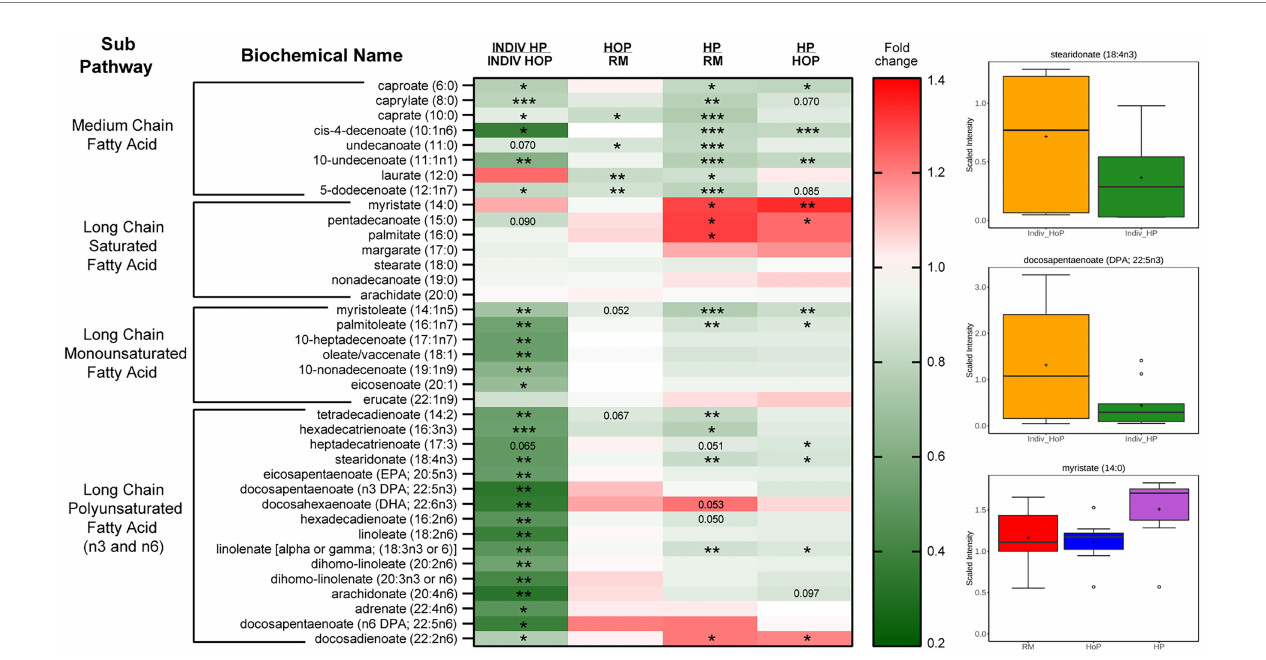
FIGURE 3 Heatmap (abbreviated) and boxplots of relevant free fatty acids in samples of cohort 1 (pooled RM-, HoP-and HP-samples) and cohort 2 (Indiv_HoP-and Indiv_HP-samples). Metabolites significantly modulated are indicated in colored cells in the table (in red: increase; in green: decrease). Fold-change is indicated in color on the right as well as p value in the table (* p ≤ 0.05, ** p ≤ 0.01, and *** p ≤